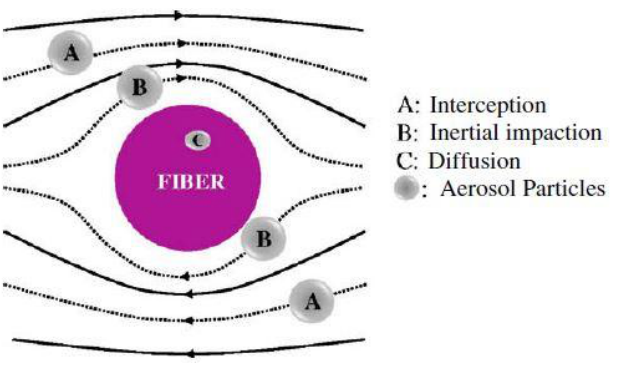
Figure 14. The main aerosol capturing mechanisms of a fibrous filter